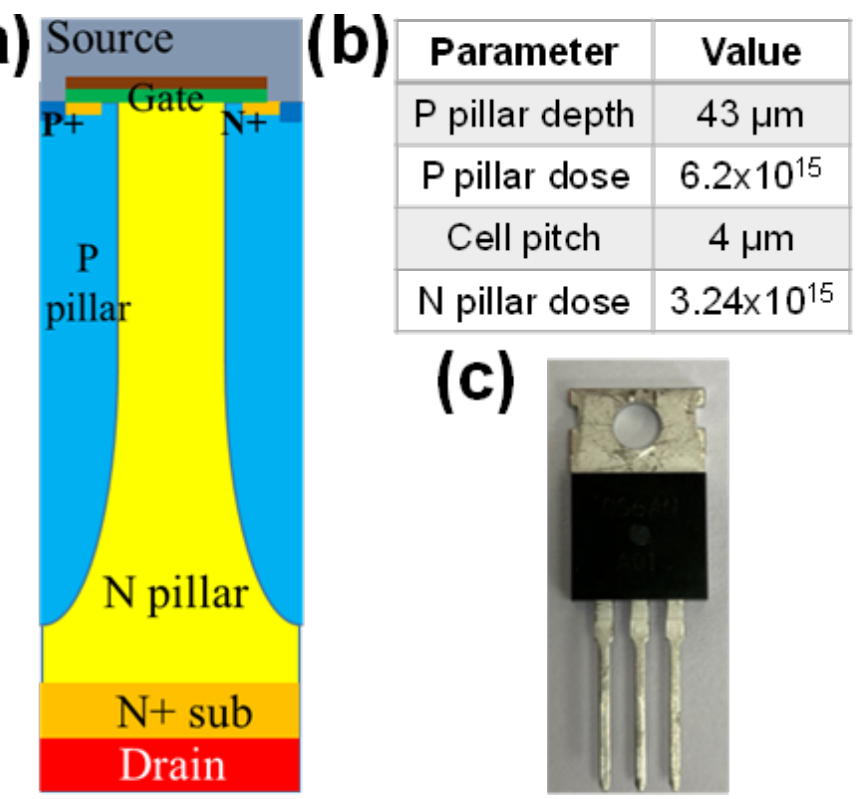
Figure 1. ( a ) Schematic of the 650-V SJ cell structure. ( b ) Main device parameter. ( c ) Photograph of a packaged SJ device.